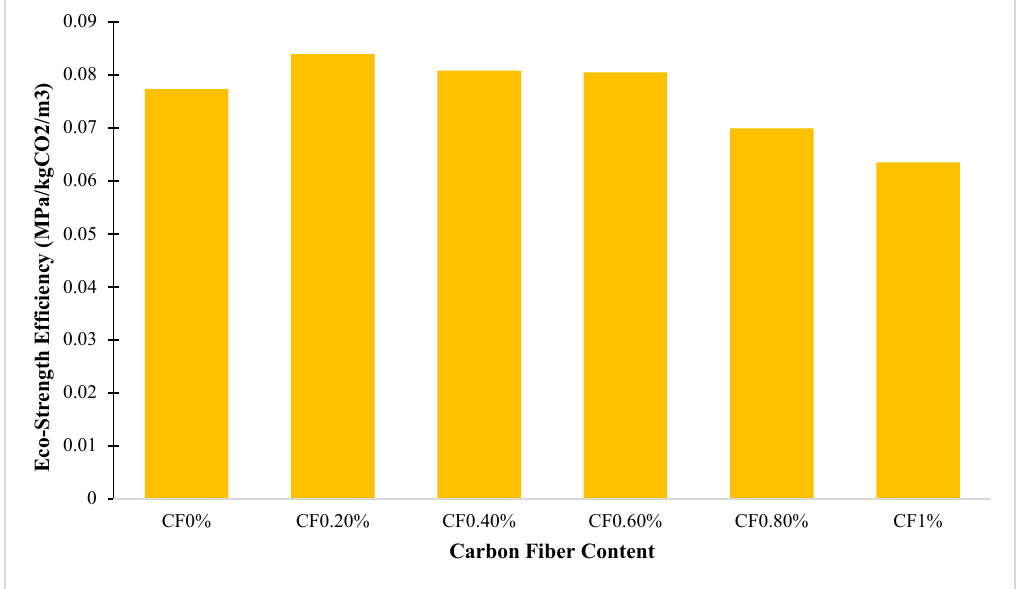
Buildings 2023 , 13 , x FOR PEER REVIEW figure for eco-efficiency.